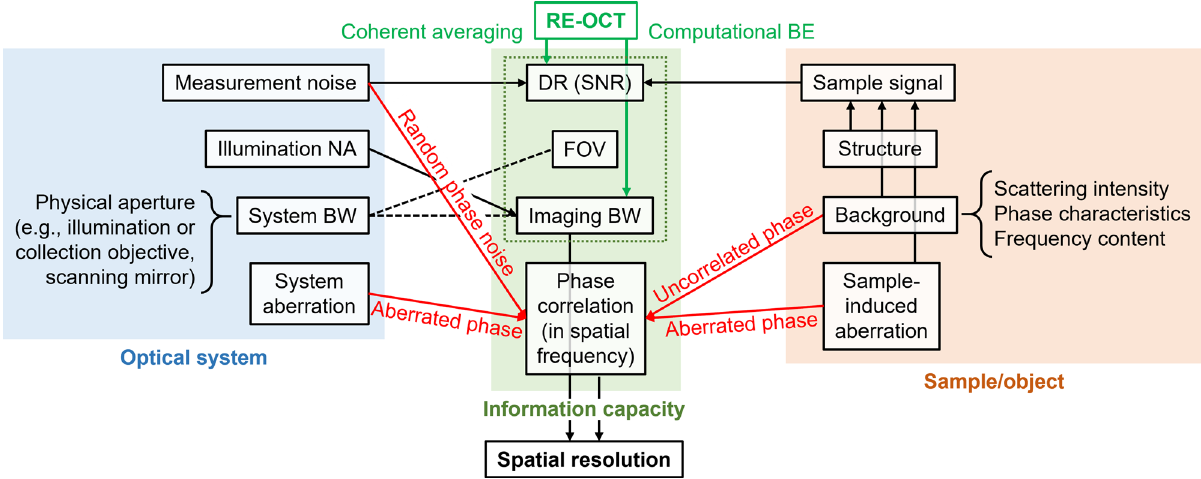
Figure 6. Expanded framework of information capacity and resolution in coherent imaging. Factors that influence elements of the expanded information capacity and ultimately affect resolution in coherent imaging. Phase correlation in the spatial-frequency domain is an important addition to the existing framework of information capacity (green dotted box) 4 . Red arrows denote factors that can disrupt phase correlation in the spatial-frequency domain. Green arrows indicate the role of RE-OCT: enhancing DR in the spatial frequency domain via coherent-average noise suppression, then, expanding imaging bandwidth via computation BE. For the sake of simplicity, the depicted framework omits the temporal components and only considers information in the spatial dimensions. Supplementary Section VII discusses the relationship between system and imaging bandwidths, illumination NA, and FOV. BW,